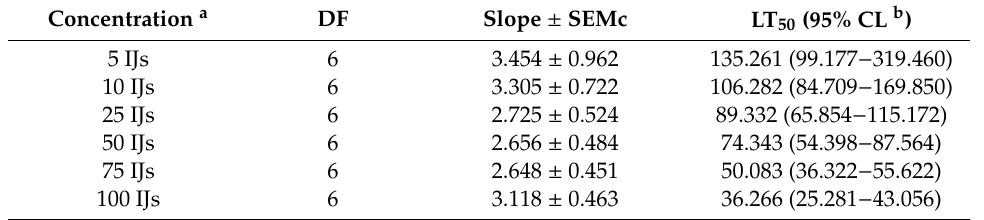
Table 5. Time e ff ect of S. litorale CTP19-1 on G. mellonella